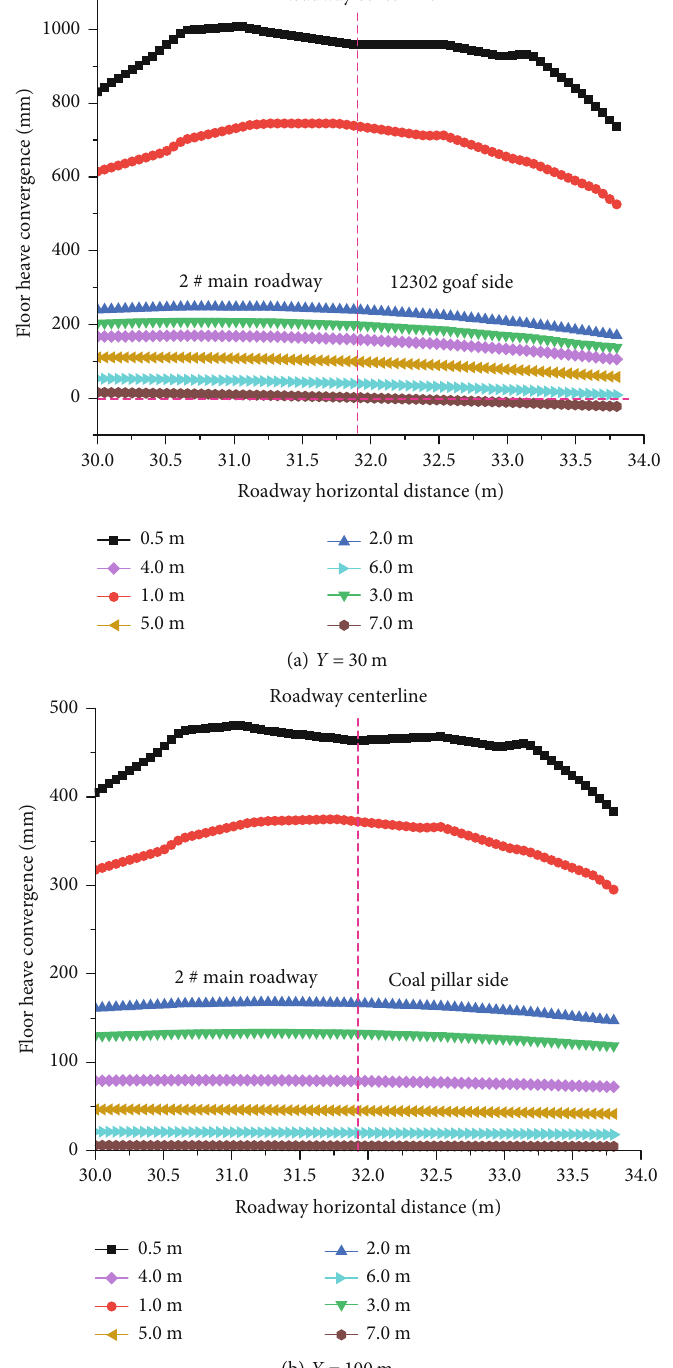
Figure 12: Floor heave